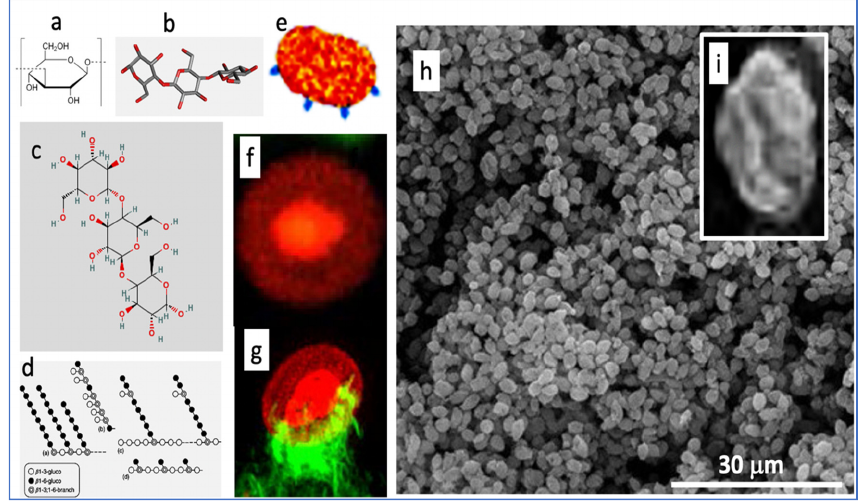
Figure 8. Various illustrations of zymosan. Panels ( a – d ) are chemical, graphical, and 3D-steric presentation of structure, ( e ) is an artistic visualization and ( f – i ) are electron microscopic and scanning electron microscopic images of zymosan. The corona in ( f ) is with a fluorescent dye conjugated to zymosan, and ( g ) is a zymosan particle undergoing phagocytosis, where the green fluorescing “claws” are macrophage pseudopods embracing the particle as first step of phagocytosis. The insert ( i ) is a particle zoomed in from ( h ). Free pictures from the internet and modified reproductions of figures in Ref. [47] with permission.